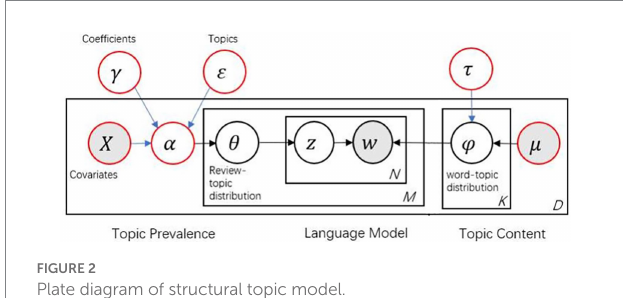
FIGURE 2 Plate diagram of structural topic